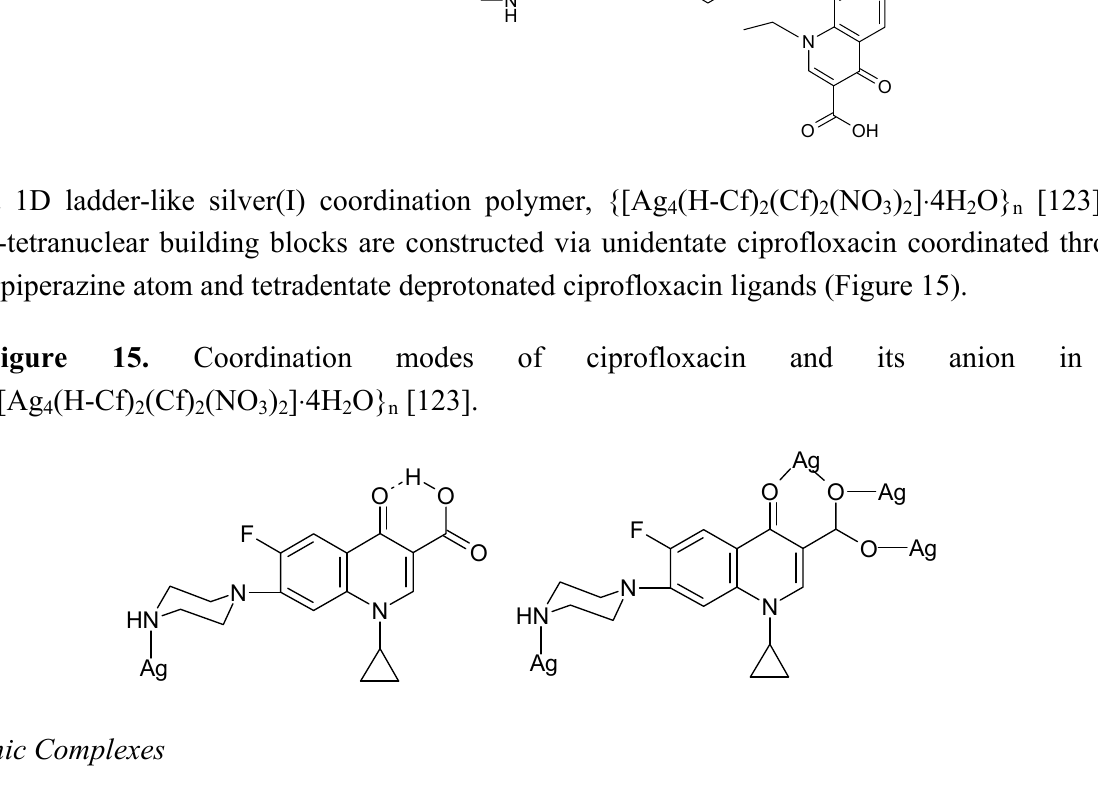
(SO ) ⋅ 2H O and 2 4 2